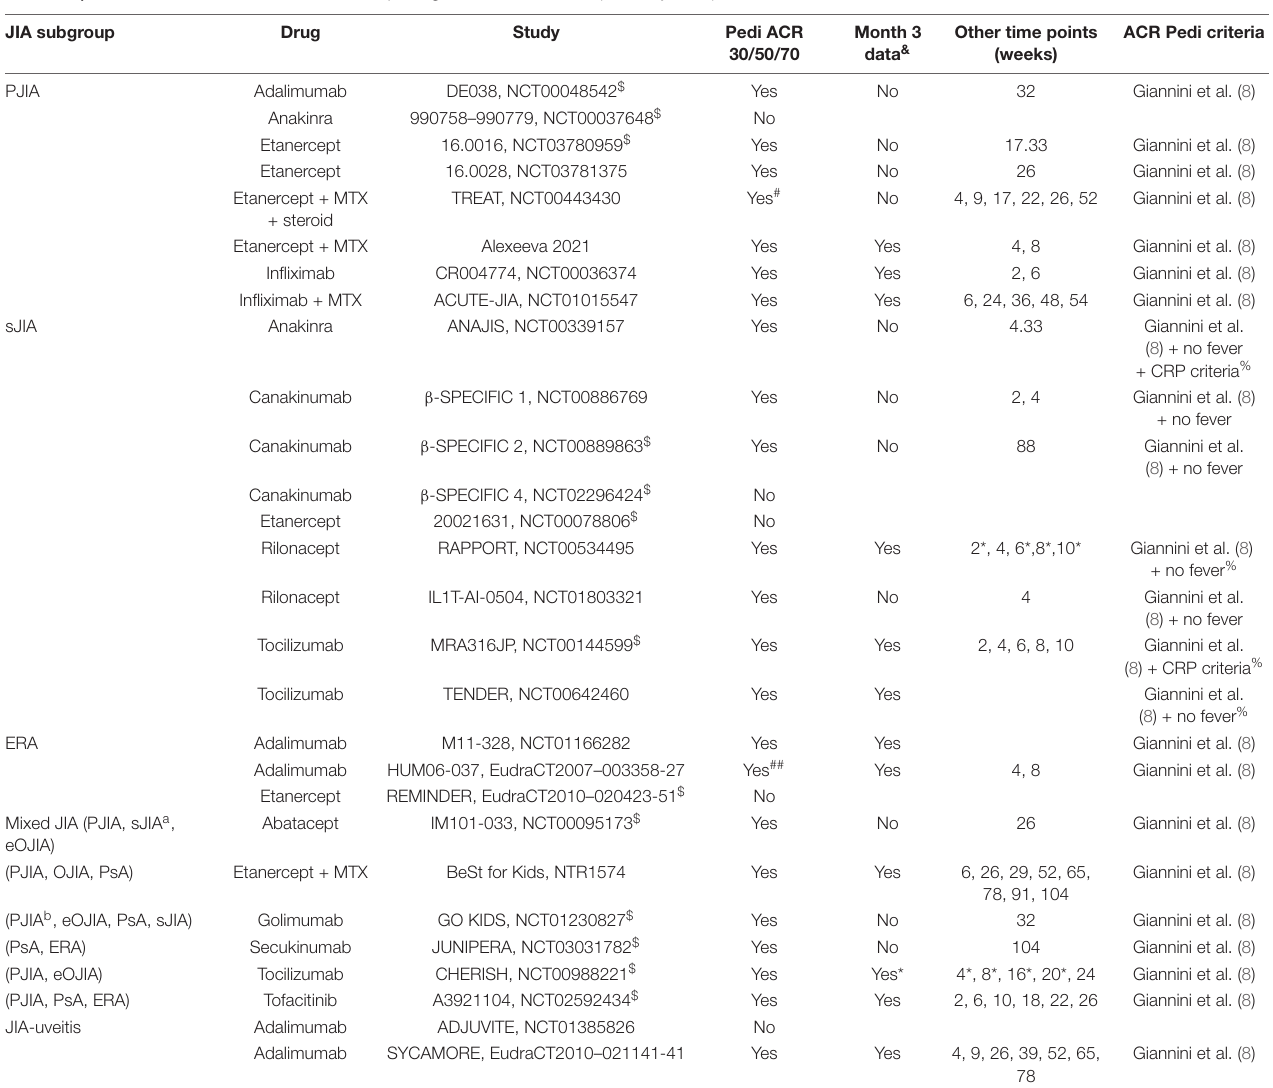
TABLE 1 | Overview of ACR Pedi 30/50/70 data reporting across 28 JIA RCTs (February 2022). JIA